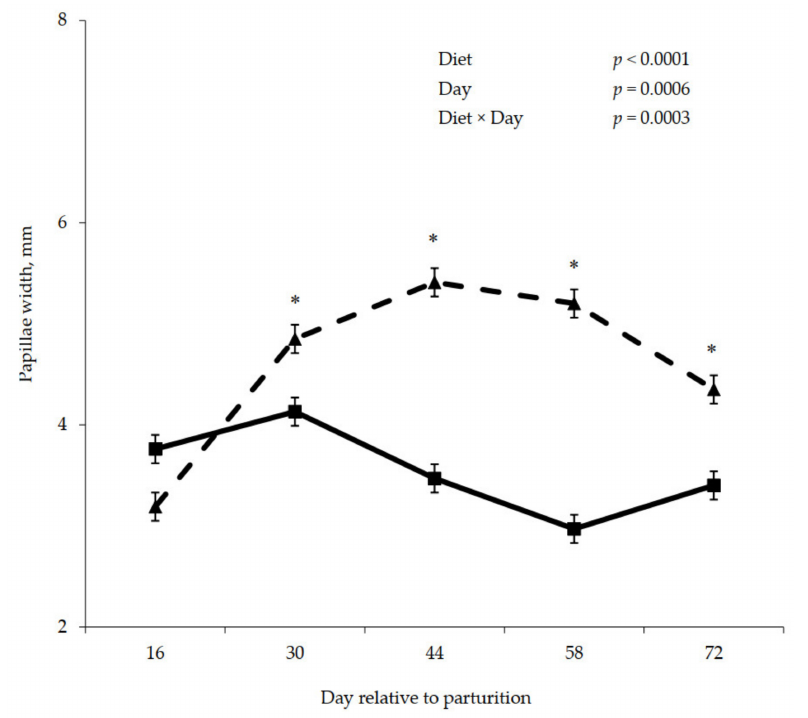
Figure 6. Postpartum rumen papillae width for cows fed control (triangles) or molasses-containing (squares) diets during a 60 day dry period (error bars = pooled standard error of the mean, Experiment 2, n = 3). * Within each day, means differ at p ≤ 0.05.